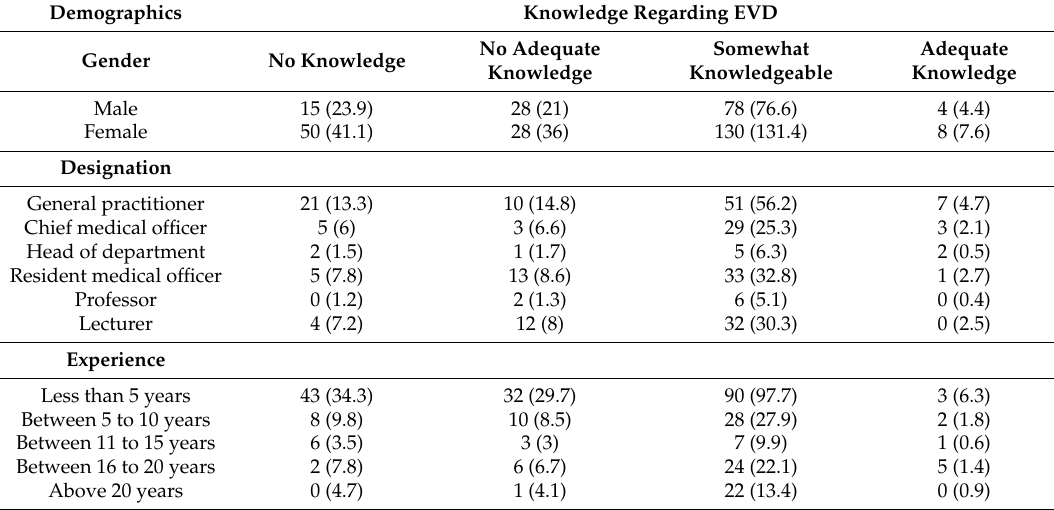
Table 2. Cross-tabulation of respondents’ demographics with